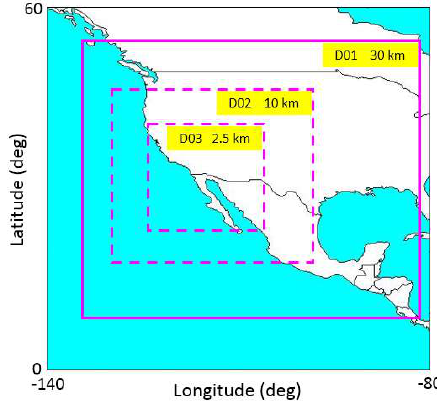
Figure 7. Configuration of the domains around the study area. Table 1. The physics schemes used in the WRF configuration.